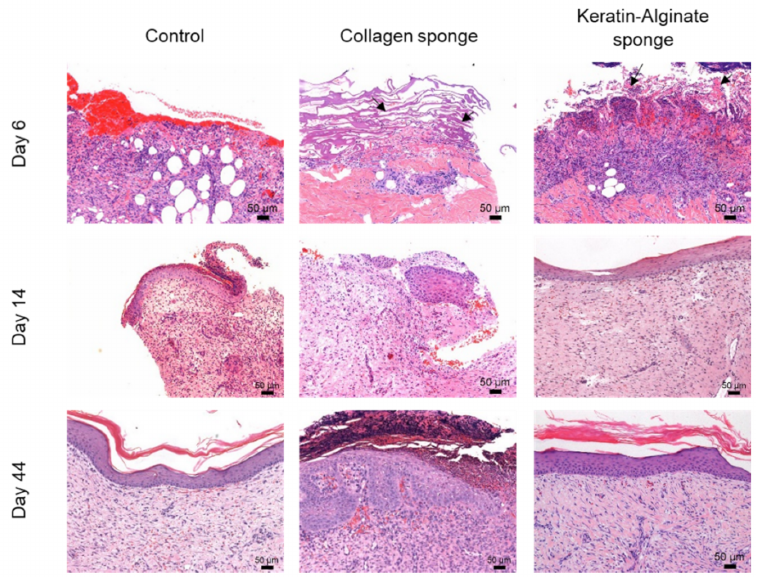
Figure 5. Hematoxylin and eosin evaluation of pig burn wounds treated with collagen and keratin– alginate sponges on days 6, 14, and 44 after grafting. Traces of the collagen and keratin–alginate sponges were evident (black arrows), indicating adequate integration into the host tissue (scale bar: 50 µ